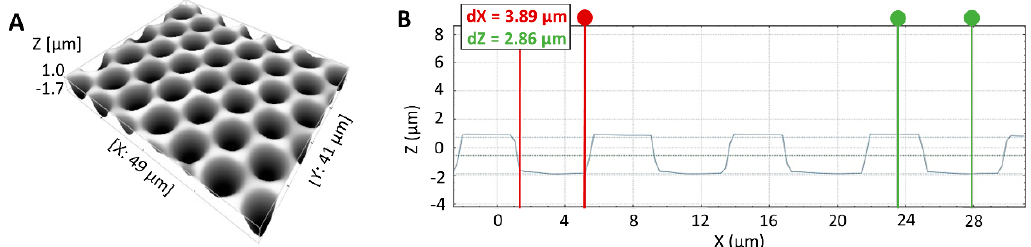
Figure 8. Microwell array, fabricated by molding, plasma etching and baking the sample upside down for 10 min at 250 °C (Procedure VII). ( A ) 3D image of the microwell array. ( B ) 2D section the microwell array with a well of 3.89 μ m in diameter (indicated in red) and 2.86 μ m in depth (indicated in green).